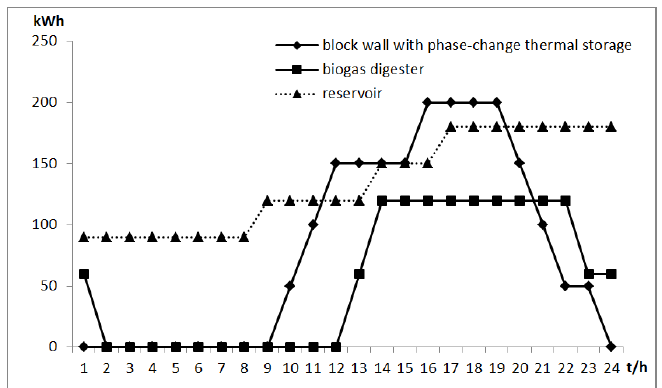
Figure 12. The stored energy curves of energy stores on a winter cloudy day after a rainy day. (4) Analysis of photovoltaic power consumption